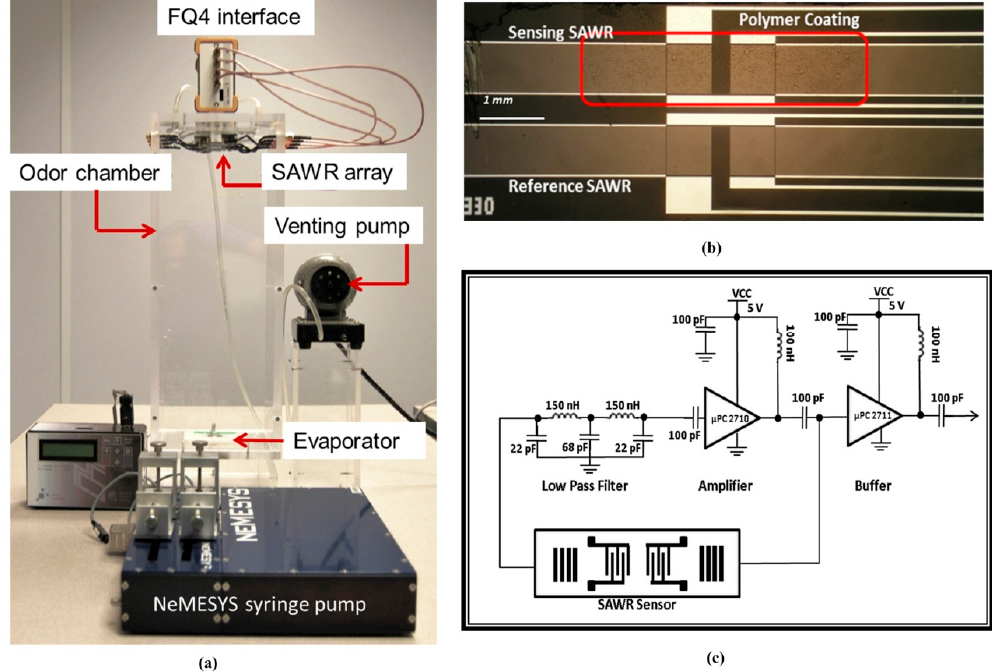
Figure 2. ( a ) Prototype of an infochemical test chamber containing syringe pump, micro-evaporator and array of polymer-coated SAWR sensor. ( b ) Optical micrograph of a 263 MHz Rayleigh mode dual SAWR with the polymer indicated on the sensing device. ( c ) Schematic block diagram of the feedback-loop oscillator circuit used for the pheromone-based ratiometric measurements.